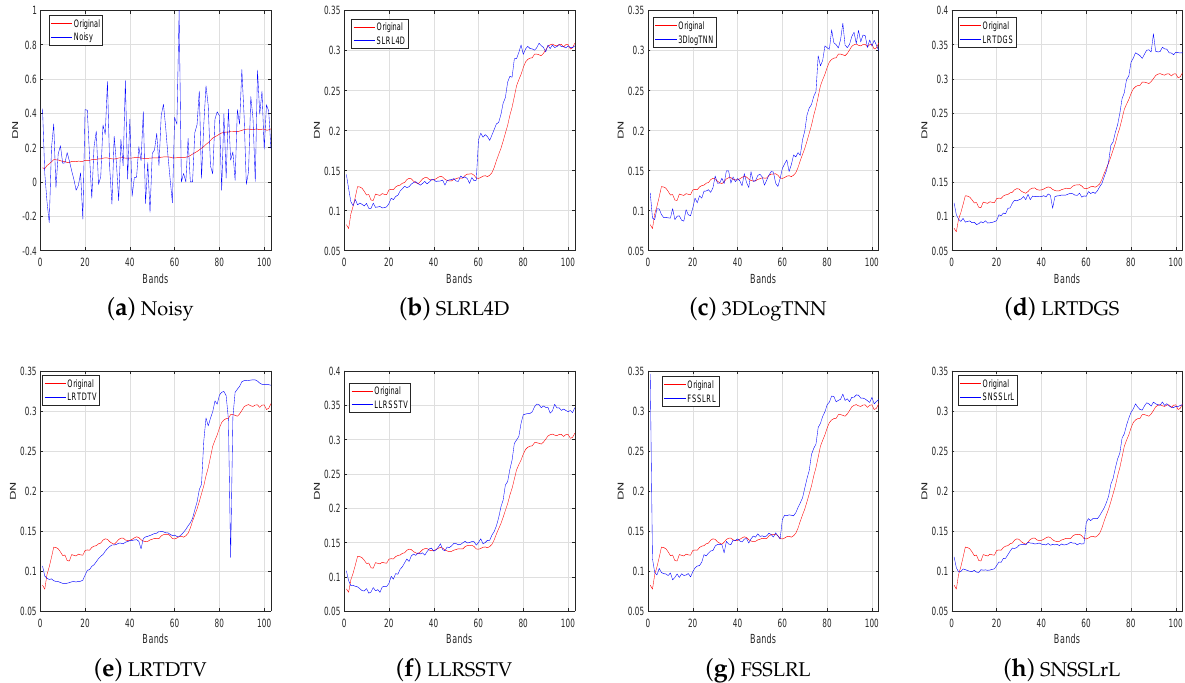
Figure 7. The compsarison of the reconstructed spectrum by different method at pixel (100, 100) in case 4 of PU dataset.